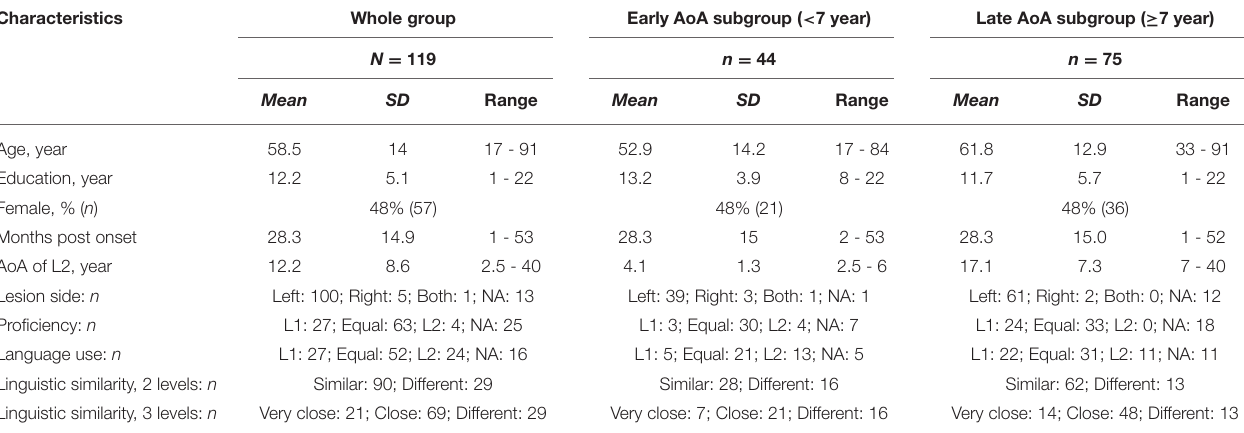
TABLE 3 | Demographic and clinical details of the whole sample and AoA subgroups.